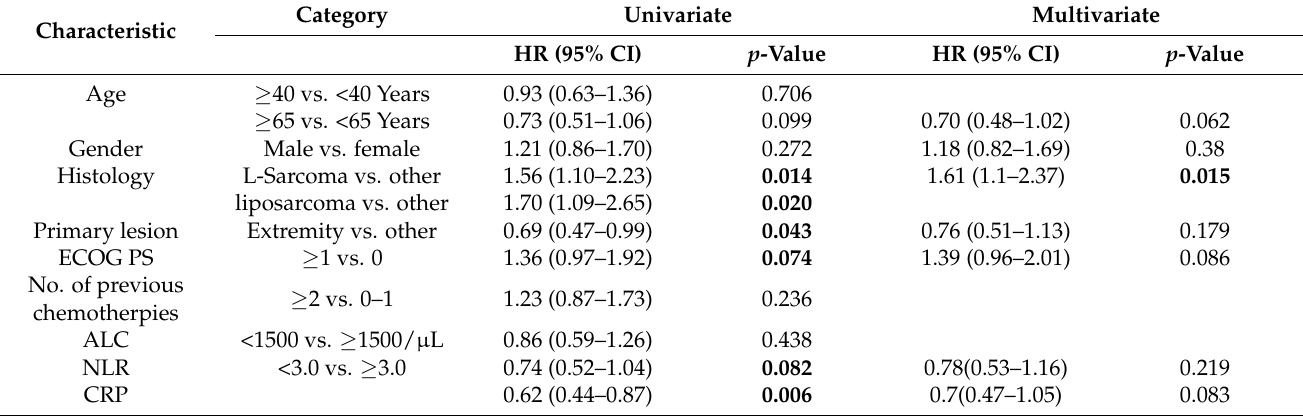
Table 5. Univariate and multivariate analyses of factors associated with progression-free survival.